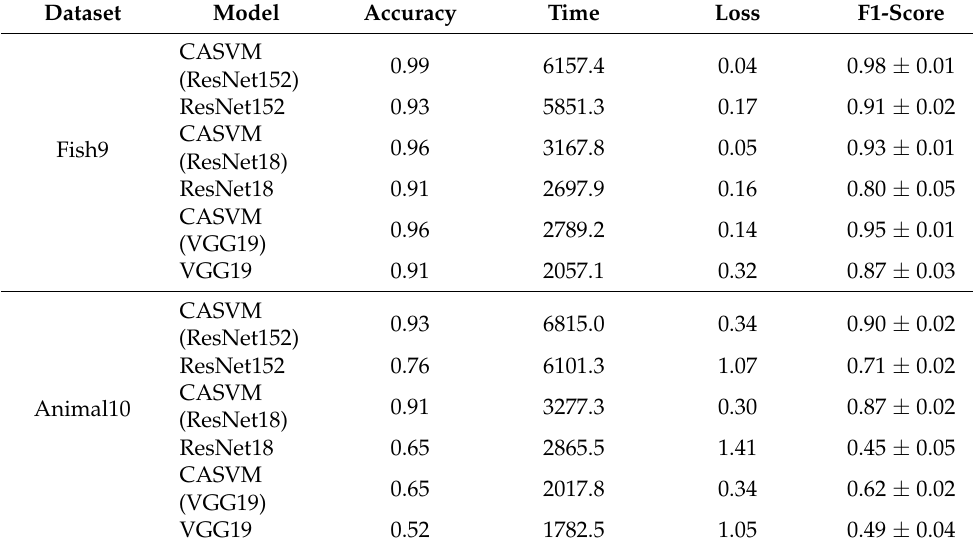
Table 7. Image classification accuracy